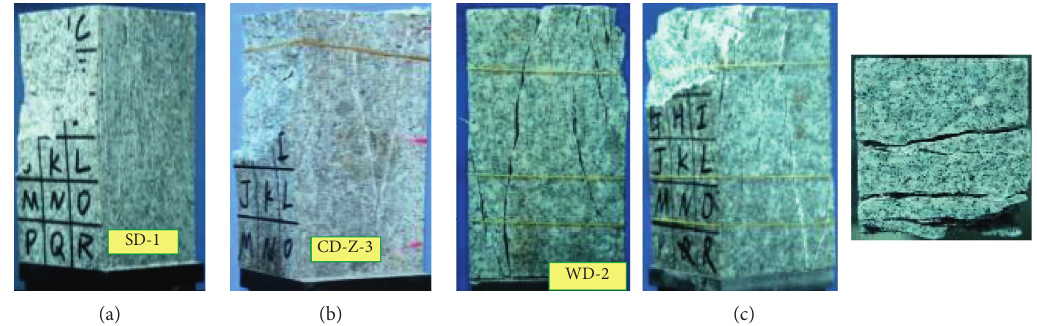
Figure 12: Comparison of typical failure patterns of rock samples of different types of rockbursts: (a) the self-initiated rockburst, (b) the moderate seismically induced rockburst, and (c) the weak seismically induced